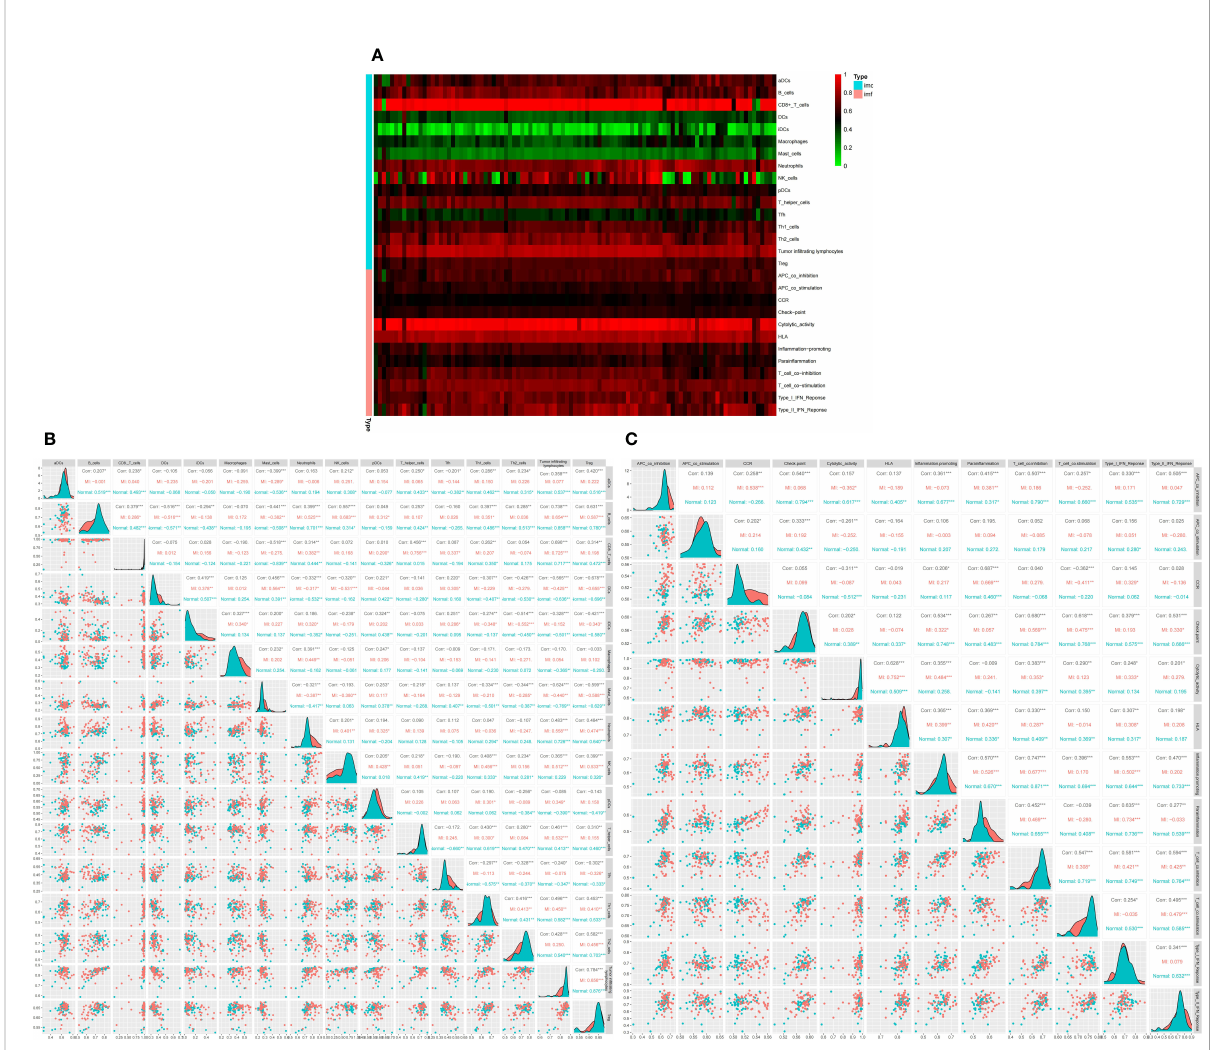
FIGURE 5 Differential expression of immune score between normal and MI groups, * indicates the signi fi cance of the correlation and the number indicates the degree of correlation. (A) Heatmap for DEGs. Each line represents one immune cell or function, and each column represents one dataset. Genes with high correlation and no correlation were represented in red and green swatches, respectively.The redder the color of each row, the higher the correlation. Imc indicates immune cells and imf indicates immune function (B) Correlation matrix of 16 signi fi cant immune cell subtypes. (C) Correlation matrix of 12 immune function subtypes. * indicates the signi fi cance of the correlation and the number indicates the degree of correlation (*P<0.05, **P<0.01,